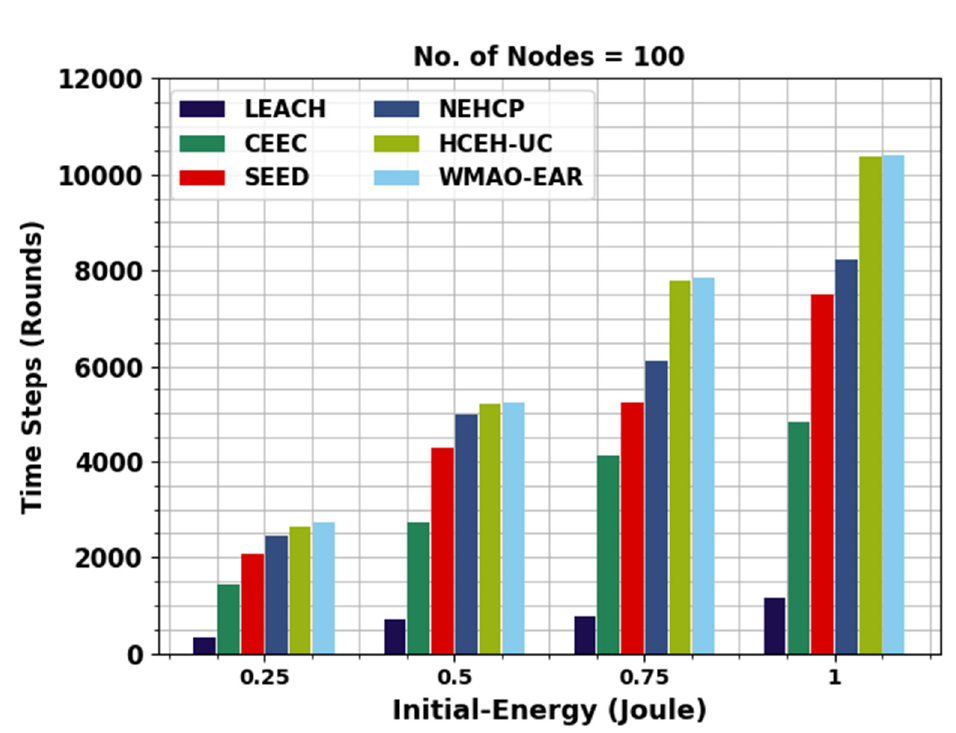
Figure 5. EU analysis of WMAO-EAR approach under NC of